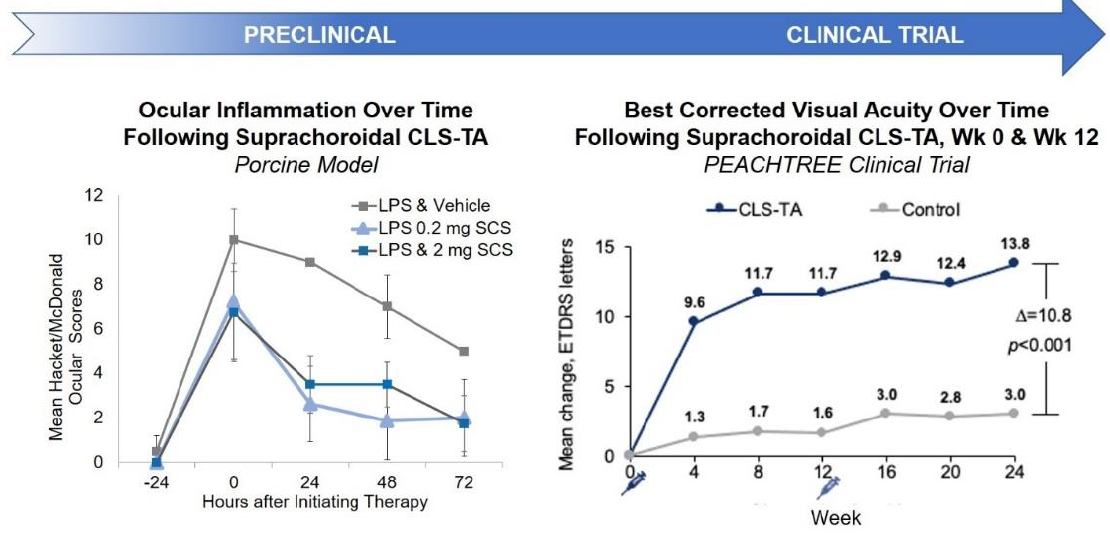
Figure 3. Preclinical and Clinical Results of SC Administration of Small Molecule Suspensions. CLS-TA: investigational formulation of triamcinolone acetonide developed by Clearside Biomedical (Alpharetta, GA, USA); LPS: lipopolysaccharides.